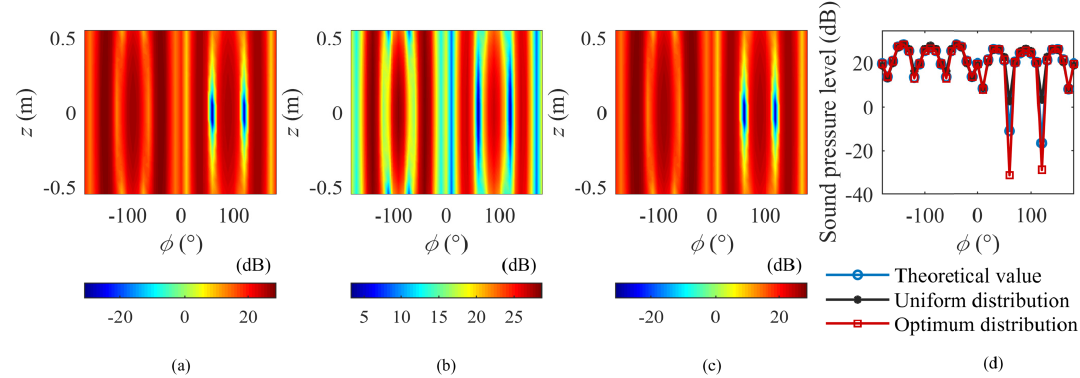
Figure 13. The SPL computed at 5000 Hz: ( a ) the theoretical value, ( b ) the value computed by the uniform distribution, ( c ) the value computed by the optimum distribution, and ( d ) the SPL along the middle row.